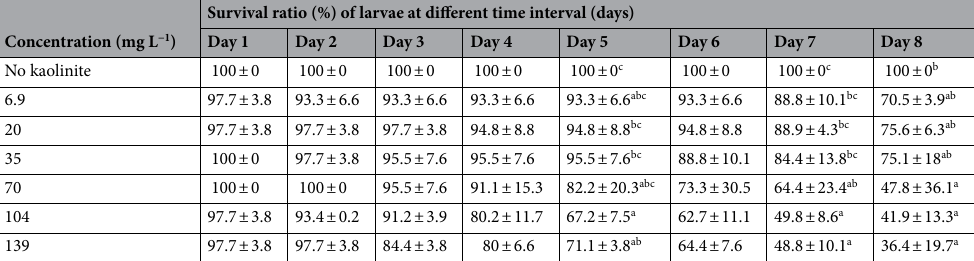
Table 2. Survival ratios (%) of elaphocaris larvae exposed to different suspended particle concentrations. Treatments with different superscripts are significantly different ( p < 0.05). All values are expressed as means ± SD ( n =